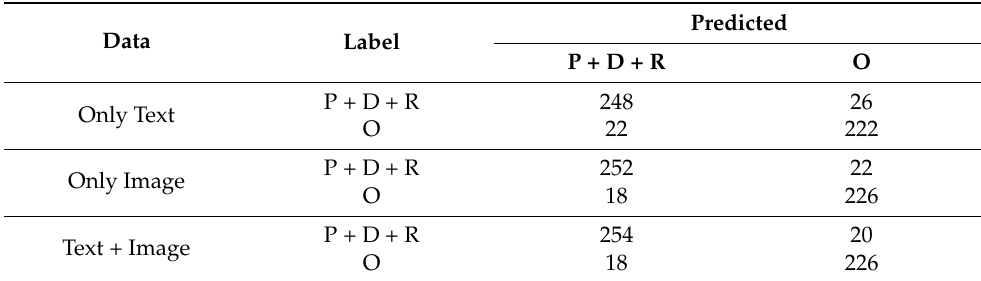
Figure 4. The accuracy of the multimodal model in the second step of Task 2.